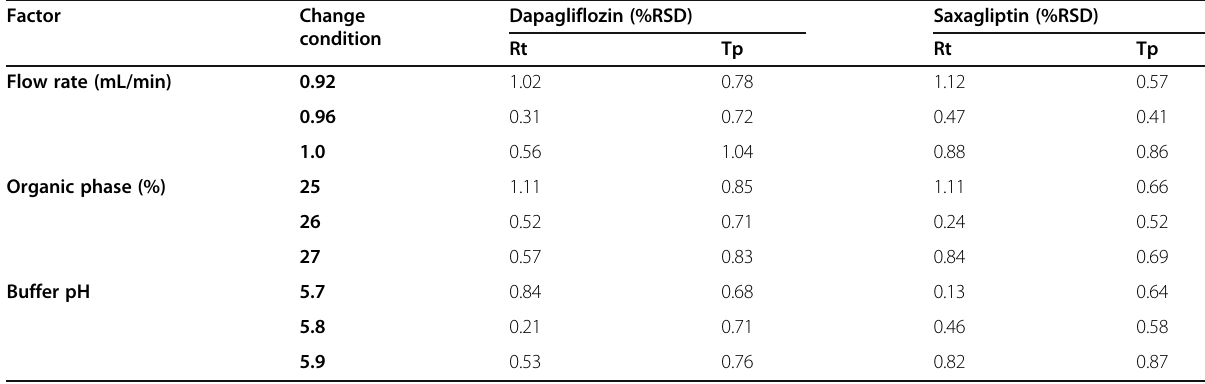
Table 4 Robustness data of optimized method